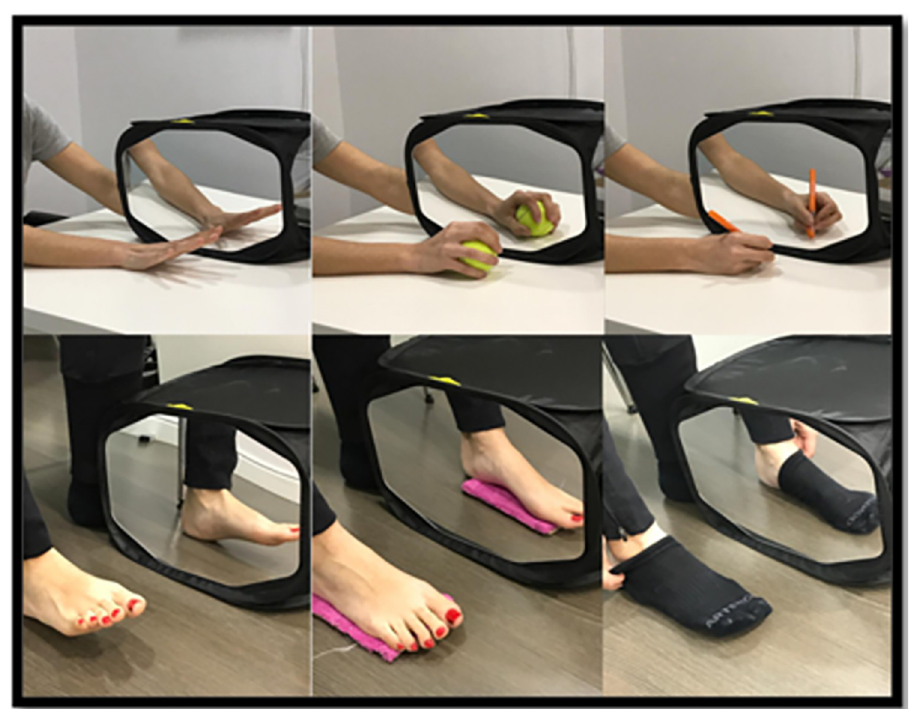
Fig 3. Progression of the images during the three weeks in the phase of mirror therapy. First week: Analytical movements of the joints involved in the amputation (left), second week: Sensory stimulation with different temperatures, textures, densities and/or vibration (centre), third week: Interaction between objects or functional activities (right).